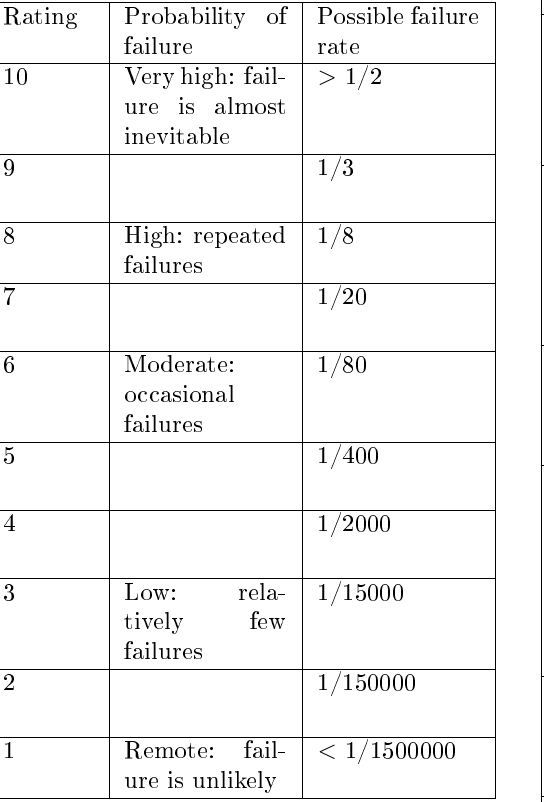
Tab. 1: Failure probability rating [12, 13].